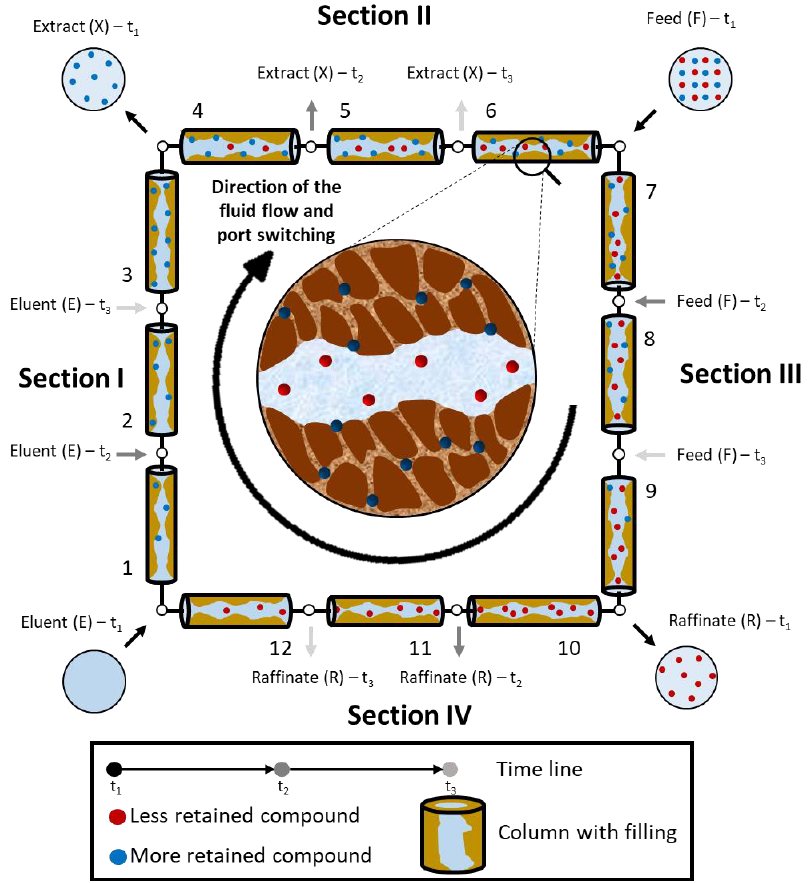
Figure 14. Schematic diagram of an SMB chromatograph and its operation where the more retained compound is adsorbed onto the solid porous phase.